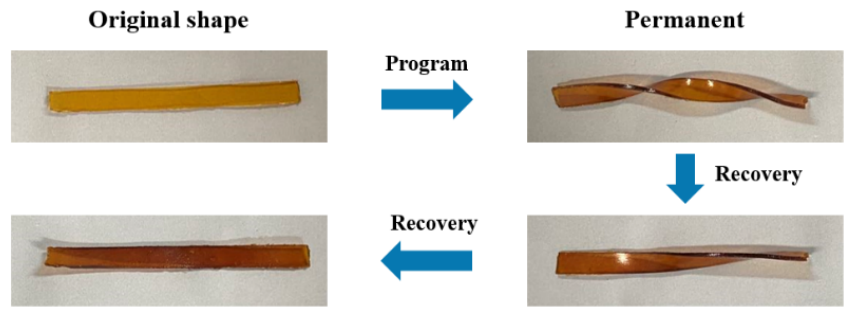
Figure 11. Shape-changing process of vitrimer 4 at 150 °C.